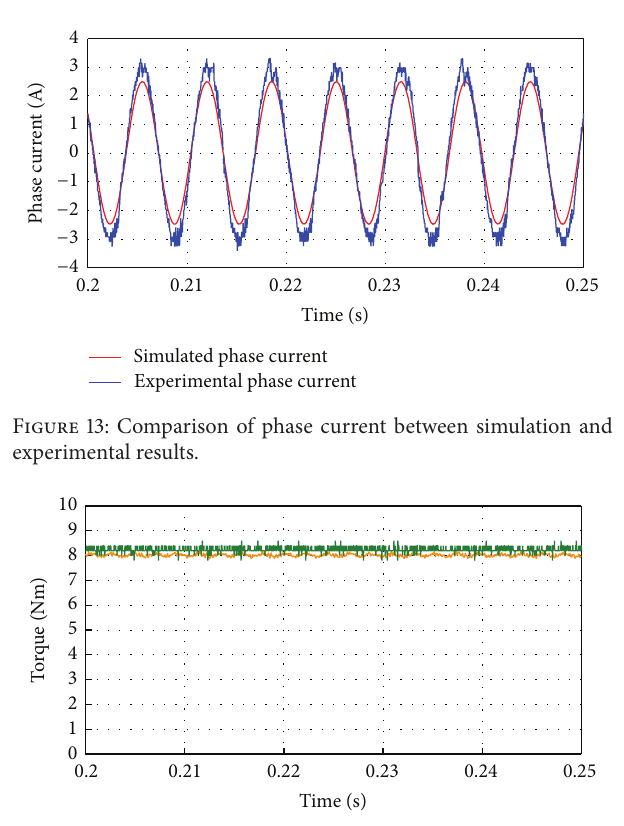
Figure 12: Measured efficiency versus load current at different speeds.